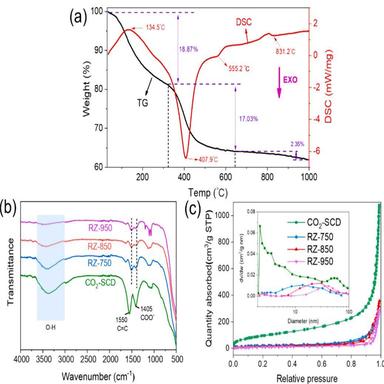
(a) TG-DSC curves of aerogel precursor in air atmosphere, (b) FTIR spectra of aerogel before and after calcination, (c) N2 adsorption and desorption isotherms and BJH pore size distribution at different heat treatment temperatures.